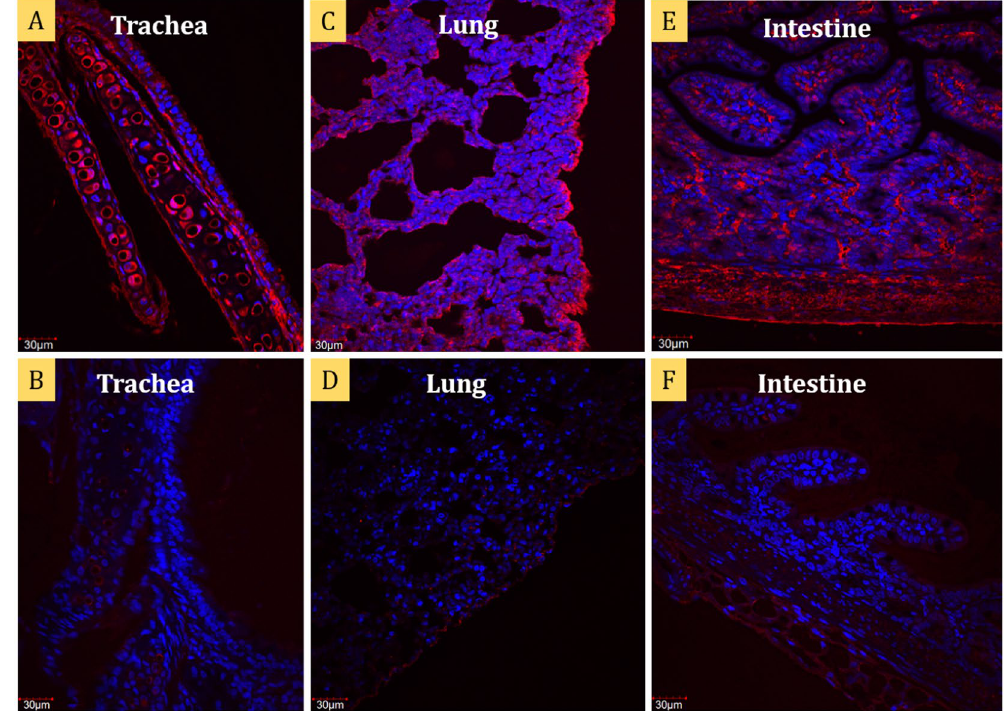
Figure 4. Widespread binding of human pandemic H1N1 virus to LBB tissues. Confocal images show extensive binding of human H1N1 virus (A/H1N1/Virginia/2009) to little brown bat (LBB) ( A ) trachea, ( C ), lung and ( E ) intestine. Binding of human pandemic H1N1 virus was in accordance with the abundance of SA α 2,6- Gal receptors in these tissues. Virus binding was observed predominantly in the submucosa and the hyaline cartilage of the ( A ) trachea, alveolar epithelial cells of the ( C ) lung and to lamina propria, muscularis and serosa of the ( E ) intestine. ( B , D and F ) mock treated trachea, lung and intestine respectively.